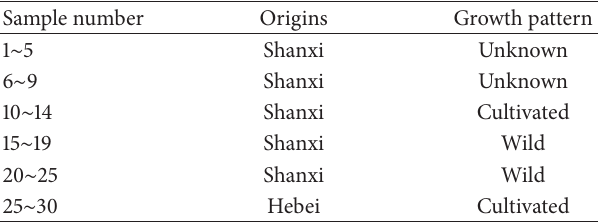
Table 1: A summary of tested samples.